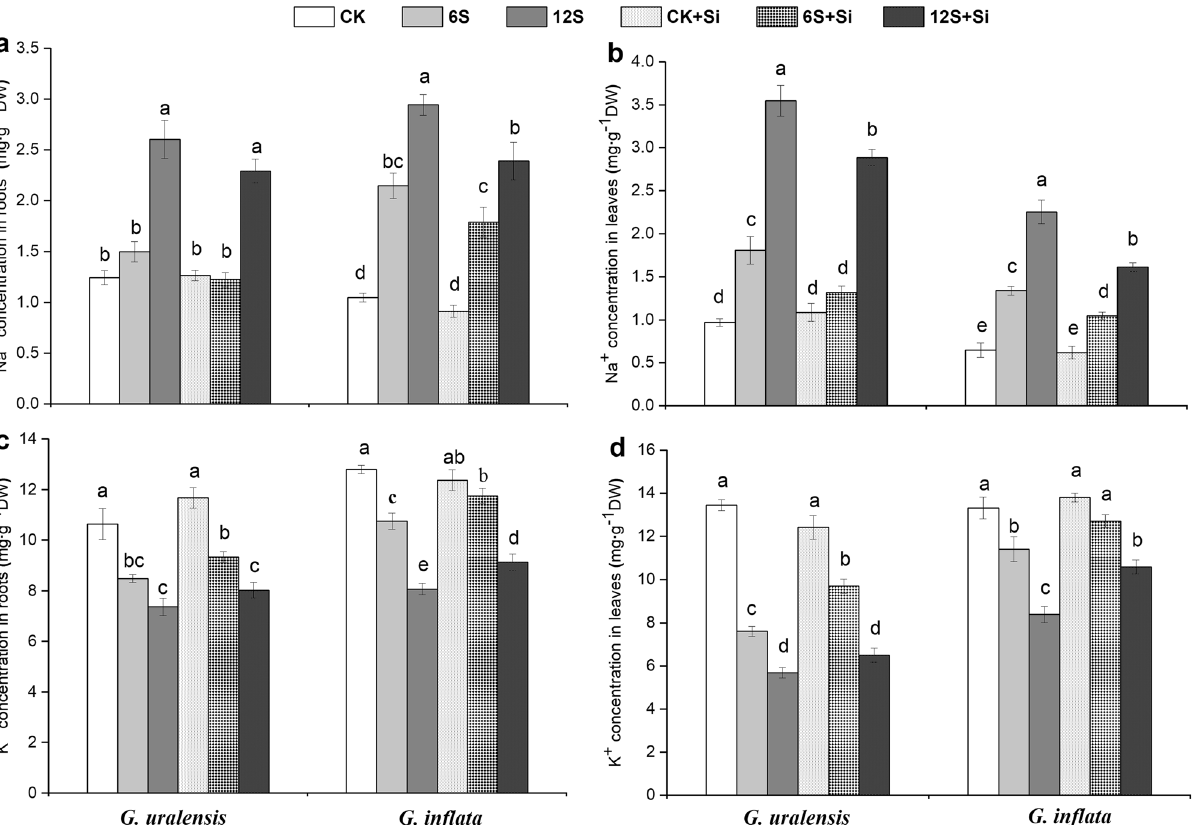
Figure 3. Effects of salinity and Si on Na + concentration in the root (a) and leaf (b) , and K + concentration in the root (c) and leaf (d) in the two liquorice species. Data are presented as the mean ± SE (n = 3). Different letters indicate significant differences between the values for one index for the same liquorice species under different treatments (P <